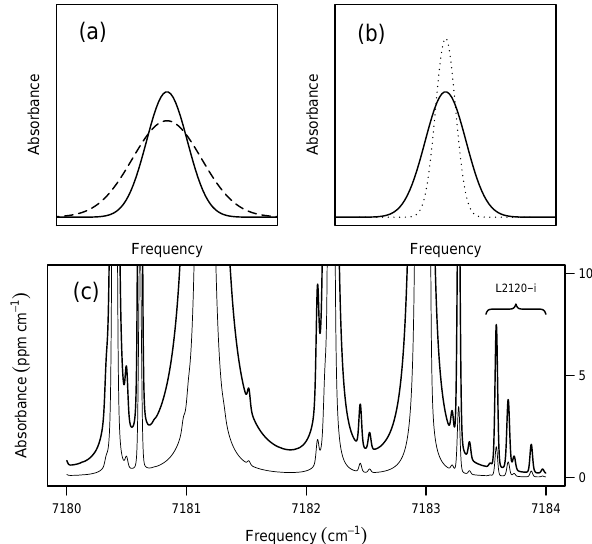
Figure 12. Direct and indirect effects of background gas compo- sition on peak amplitude determination. Panels (a) and (b) plot theoretical spectrograms illustrating how isolated absorption fea- tures are directly broadened by air (solid line) versus N 2 (dashed line) or O 2 and Ar (dotted line). Panel (c) plots simulated spec- trograms illustrating how the baseline of the three H 2 O lines tar- geted by the L2120- i is indirectly affected by the strong neighboring lines at lower frequencies. Simulations were performed using spec- traplot.com (Goldenstein et al., 2017a) with HITRAN/HITEMP data and the following parameters: T = 80 ◦ C, P = 35torr, and L = 1cm. The thick line is a simulation at 2.5% H 2 O, and the thin line is a simulation at 0.5% H 2